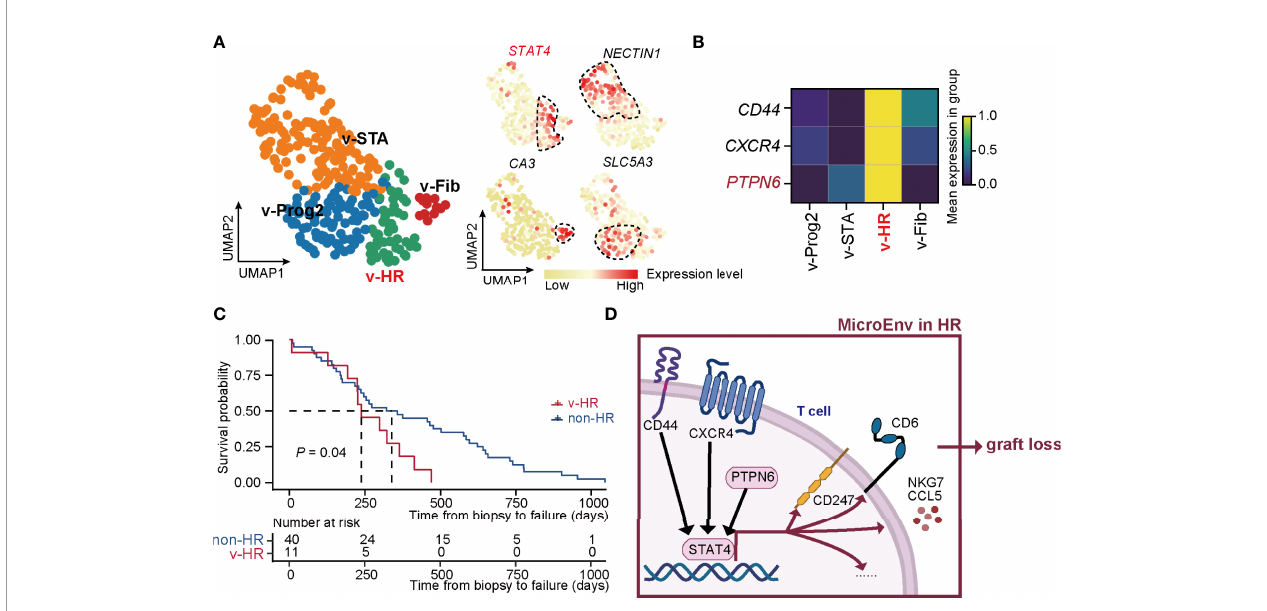
FIGURE 5 | New classi fi cation pipeline re-con fi rms STAT4 -mediated allograft loss in HR rejection. (A) UMAP plots showing the validation dataset and its annotation based on the marker genes of rejection states. The black dashed box represents the corresponding state. (B) Matrix plot showing the expression level of CD44 , CXCR4 , and PTPN6 in each rejection state. (C) The survival curve of patients with HR versus non-HR rejection of renal transplantation. (D) Diagram of renal allograft failure triggered by HR rejection that is mediated by PTPN6 - STAT4 -immune responsive signaling in T cells. MicroEnv,